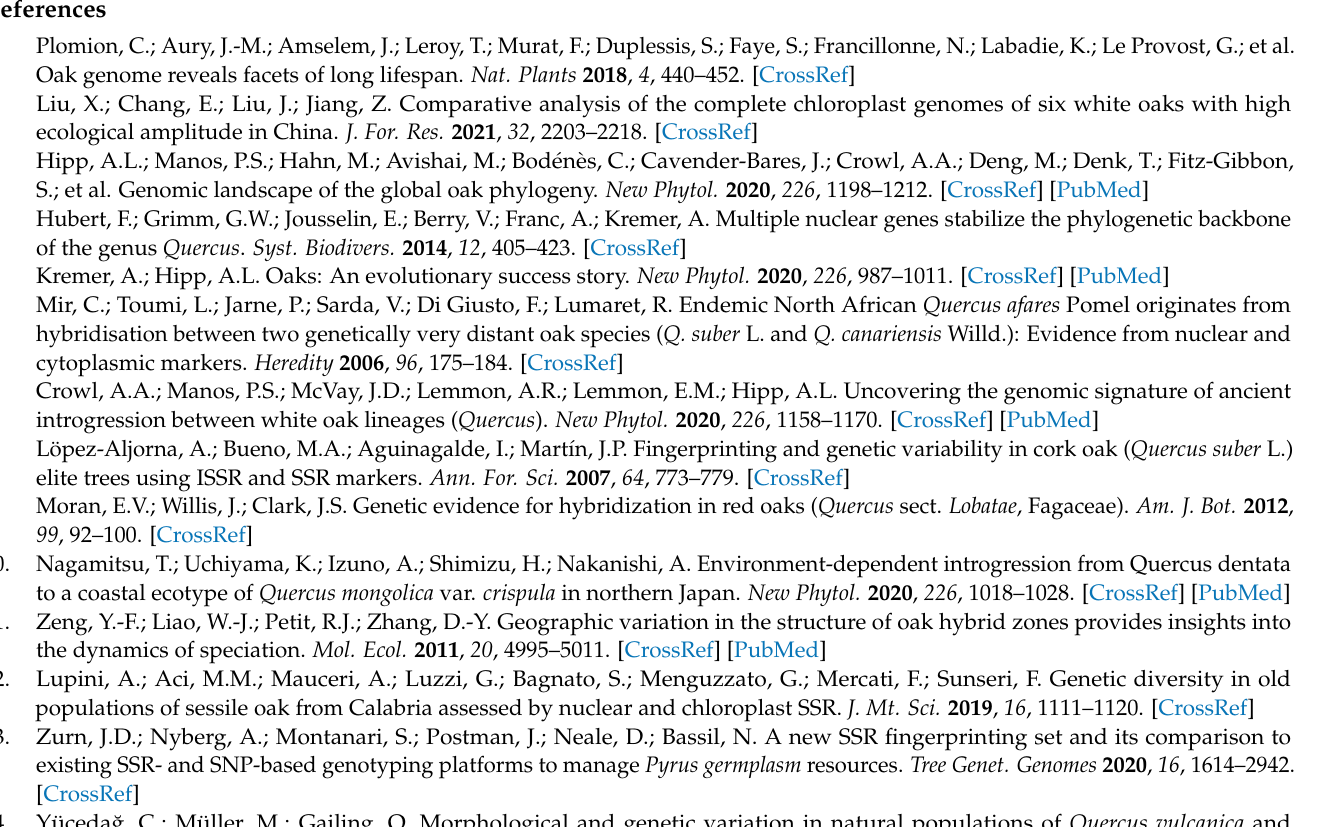
primers. Table S2: Sample information. Table S3: Information of the 9 SSR primers. Table S4: DNA fingerprints of 400